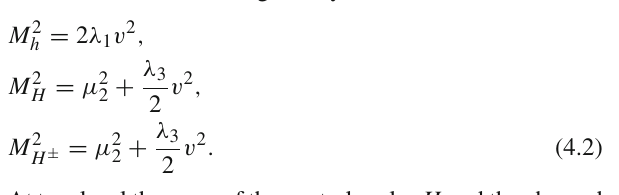
Fig. 2 The thin blue band corresponds to the relic density, (cid:19) h 2 = 0 . 1198 ± 0 . 0026 ( 3 σ) from the combined data of WMAP and Planck [63]. a The mass difference (cid:16) M (green line) and the effective annihilation cross-section (black line) as a function of the dark matter